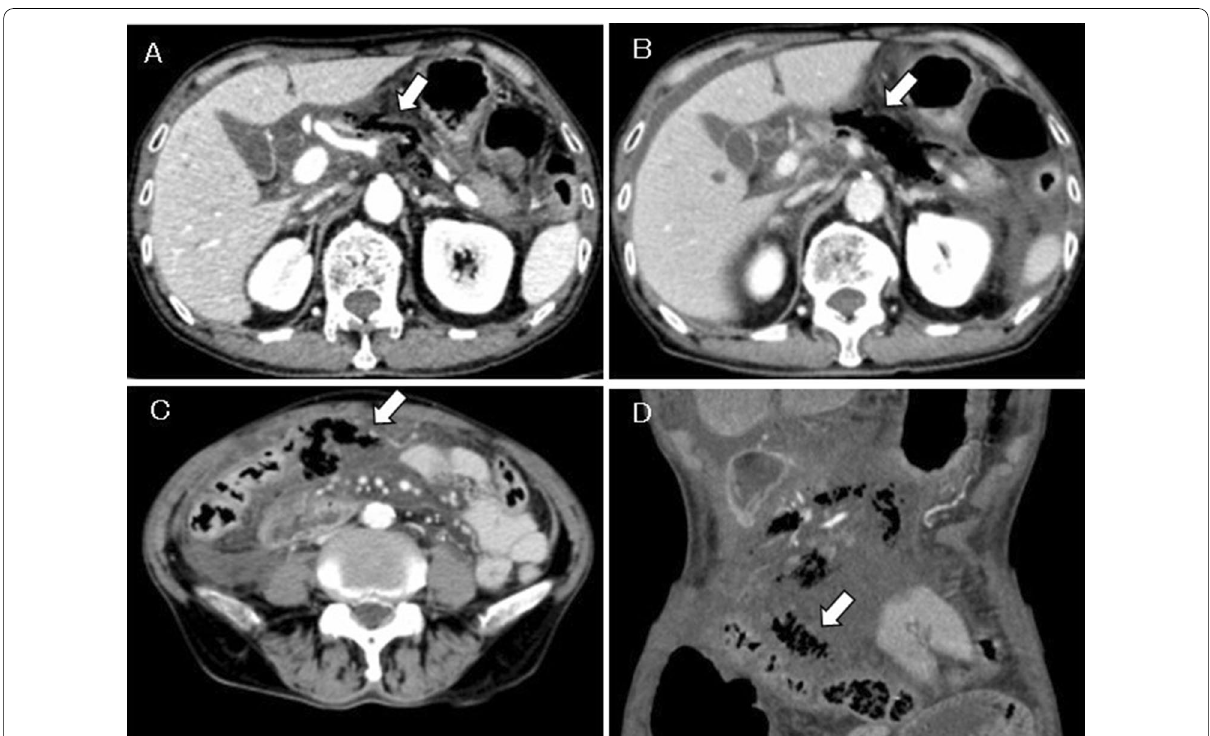
Fig. 1 Contrast-enhanced CT scan of case 1. A Initial CT showing the emphysema around the pancreatic body (arrow). B CT performed 6 h post-admission showing a significant increase in retroperitoneal gas (arrow). C , D CT performed 6 h post-admission showing the appearance of gas in the transverse mesocolon